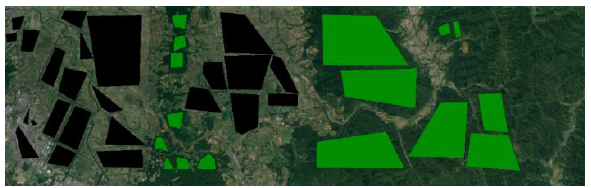
Figure 2: Distribution of Ground Truth Data on the RGB